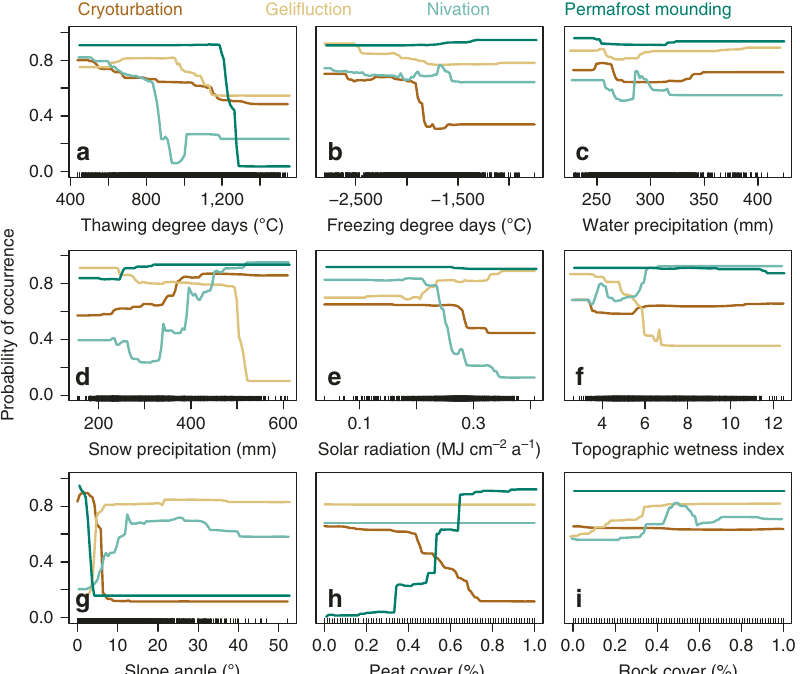
Fig. 4 The relationships between the investigated cryogenic land surface processes and environmental predictors. Partial dependency plots estimated by generalized boosting method (GBM) depict the effect of a predictor ( a thawing degree days, b freezing degree days, c water precipitation, d snow precipitation, e solar radiation, f topographic wetness index, g slope angle, h peat cover, and i rock cover) on LSP (indicated with coloured lines: dark brown = cryoturbation, light brown = geli fl uction, turquoise = nivation, dark green = permafrost mounding) after other predictors have been fi xed to their mean